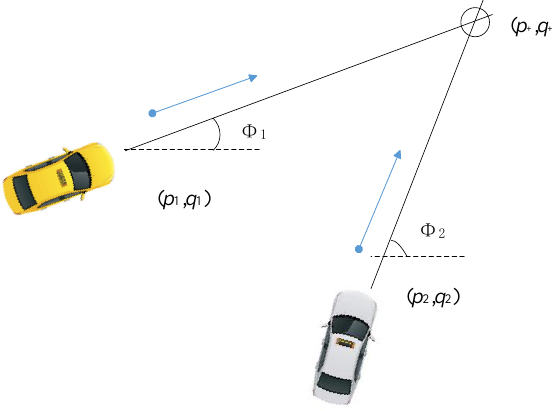
Figure 3. An example of collision prediction.